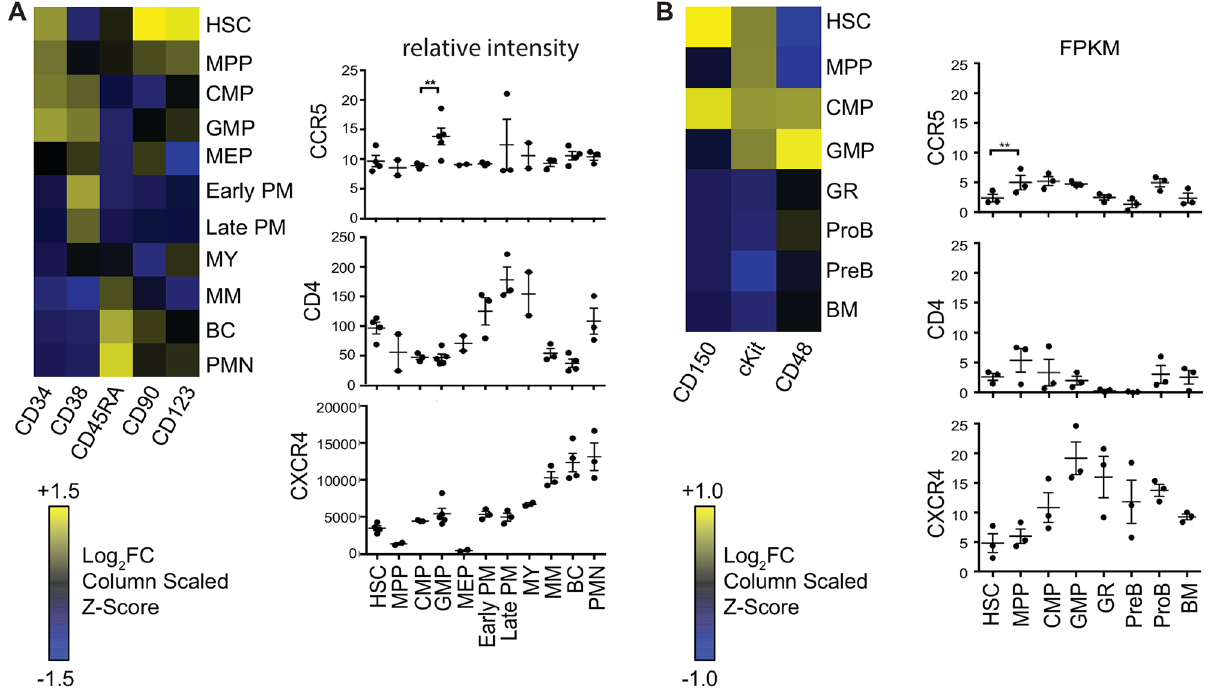
Fig 3. Expression of HIV receptors in progenitor cells. A. Affymetrix array data of gene expressionin humanbone marrow stem and differentiatedcell types extracted from a publisheddata set [12] accessedvia the NCBI Gene Expression Omnibus database(GSE42519). Left panel, heat map representingthe z-score (scaledfor each column)of the log transformed gene expression data. Right panel, relative expressionlevels of HIV receptors in each subset. The originalmicroarray data went through background correction, normalization, and log transformation via the RMA method. For the right panel,data was convertedfrom log transformed to linear. B. RNA seq analysisof mouse bone marrow and differentiatedcell types. Left panel, heat map representingthe z-score (scaledfor each column)of the log transformed gene expressiondata. Right panel, relative expression levels of HIV receptors in each subset. Mean ± SEM is shown. (Abbreviations: FC, fold change; HSC, hematopoietic stem cell; MPP, multipotent progenitor; CMP, common myeloidprogenitor; GMP, granulocyte-monocyte progenitor; MEP, megakaryocyte-erythrocyte progenitor; PM, promyelocyte; MY, myelocyte; MM, metamyelocytes; BC, band cell; PMN, polymorphonuclear cells; GR, granulocyte; ProB, pro-B cell; PreB, pre-B cell; BM, unfractionated bone marrow. FPKM, Fragments Per KilobaseOf Exon Per Million Fragments Mapped)( * p < 0.05, ** p < 0.01, *** p < 0.001, **** p < 0.0001, 2-tailedunpairedt test).